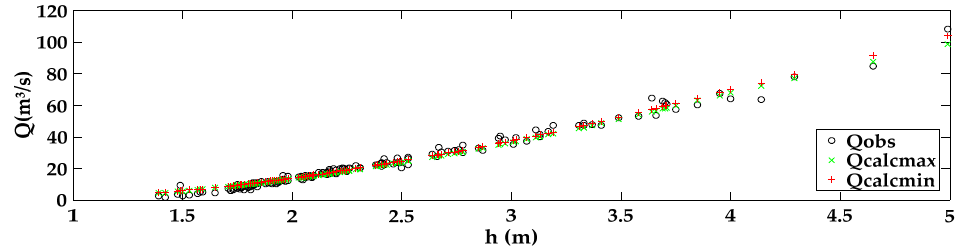
Figure 12. Interval of calculated and observed discharges—DREAM.